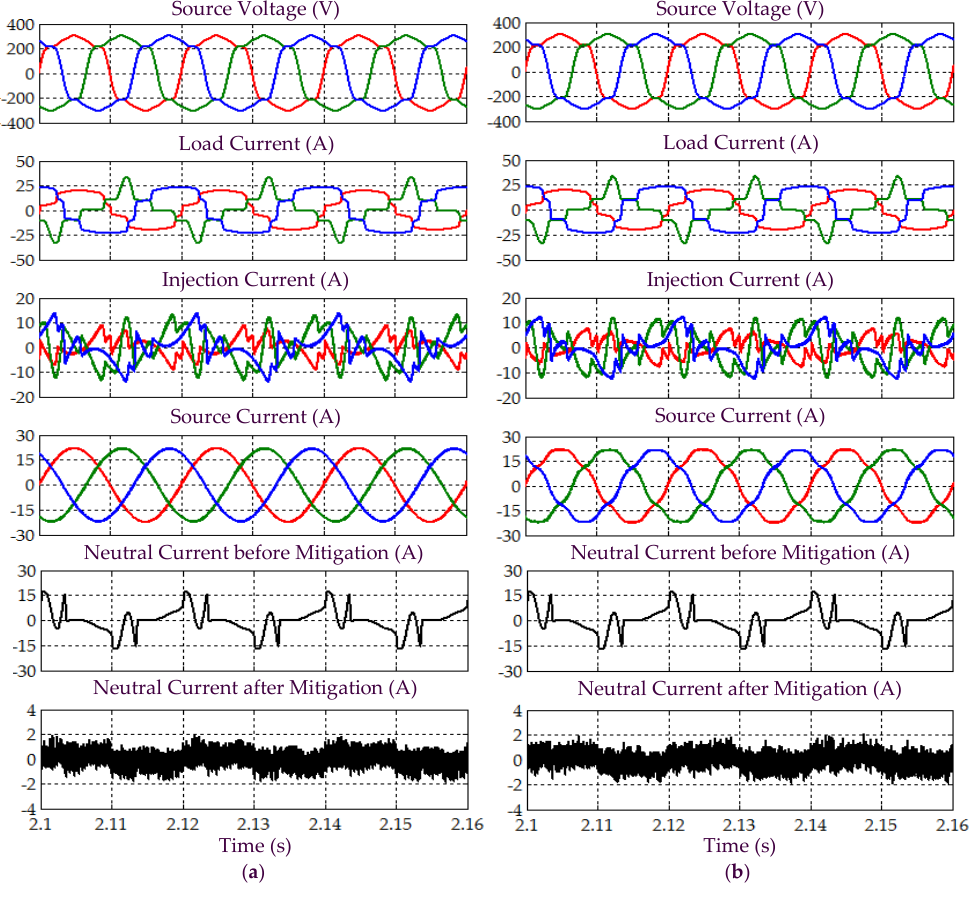
Figure 13. Simulation results obtained under Scenario B for Load 2, which include three-phase source voltage 𝑣 𝑆𝑎𝑏𝑐 , load current 𝑖 𝐿𝑎𝑏𝑐 , injection current 𝑖 𝑖𝑛𝑗𝑎𝑏𝑐 , source current 𝑖 𝑆𝑎𝑏𝑐 , and neutral current before and after mitigation, demonstrated by SAPF while applying the ( a ) proposed STF- dq 0 and ( b ) standard dq 0 techniques.